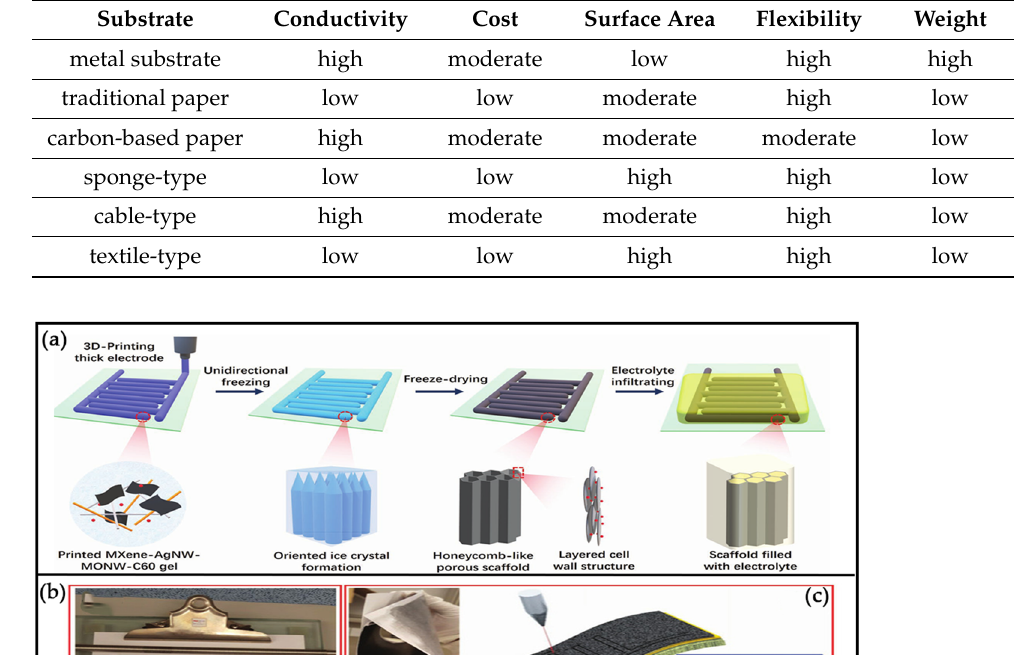
Table 1. Comparison of various flexible substrates for the flexible SC electrodes.